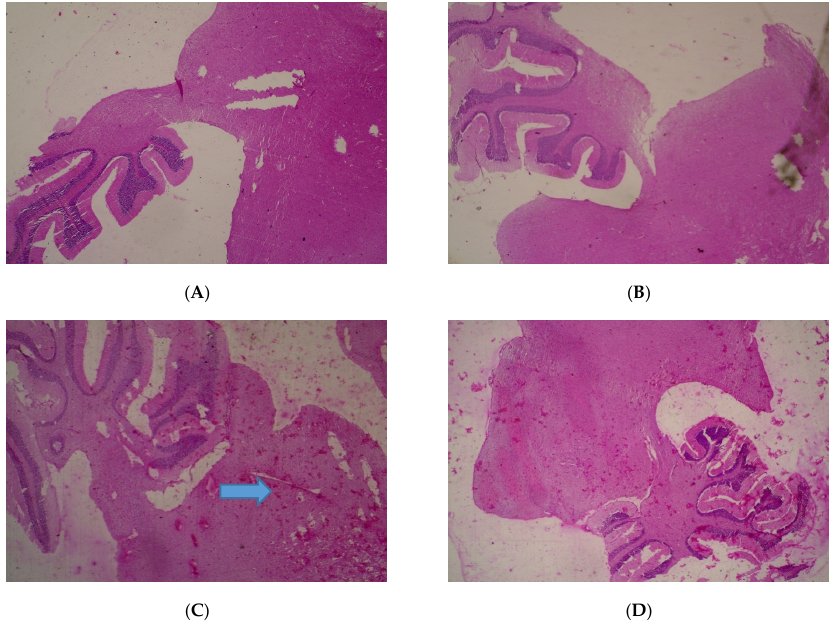
Figure 1. Histopathological presentations of rat brain. ( A ) represents the control group treated with distilled water (Normal); ( B ) represents the group treated with 80 mg/kg T. occidentalis extract (Normal); ( C ) represents the group treated with 400 mg/kg T. occidentalis extract (cerebral edema) and ( D ) represents the group treated with 2000 mg/kg T. occidentalis extract (Normal) (×400). Histologic sections of brain tissue (( A ), ( B ) and ( D )) show normal neuronal cells on a background of neuropil. However, ( C ) shows cerebral edema as evidenced by clearing (spaces) around small blood vessels in the brain parenchyma (perivascular halos or clearing) — indicated by the arrow.